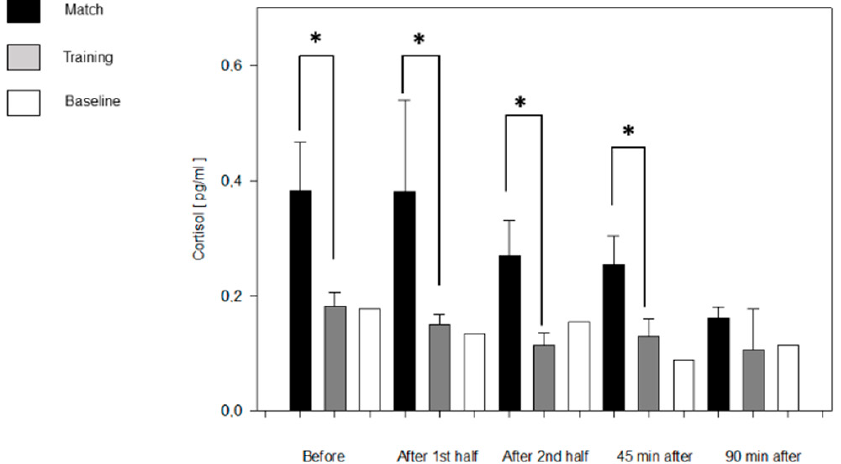
Figure 3. Salivary cortisol (C) values collected before, at halftime, directly after, and 45 and 90 min after, for the match, training, and the baseline with significant differences between match–training time points indicated with *.